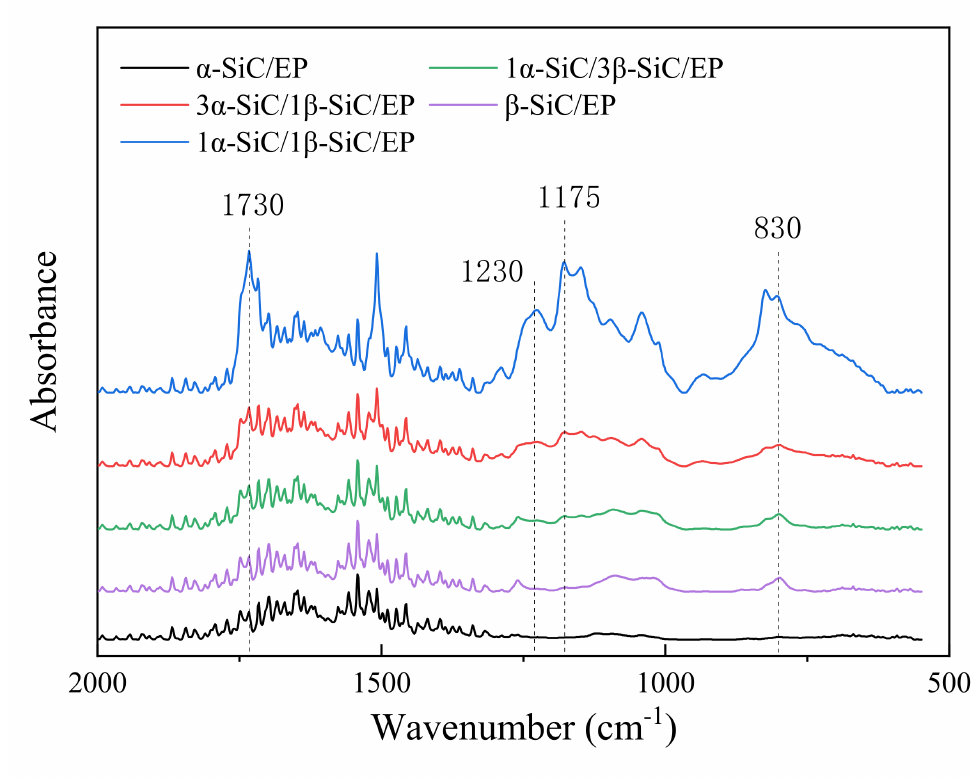
Figure 7. Partial enlarged view of baseline correction of different crystal SiC/EP infrared